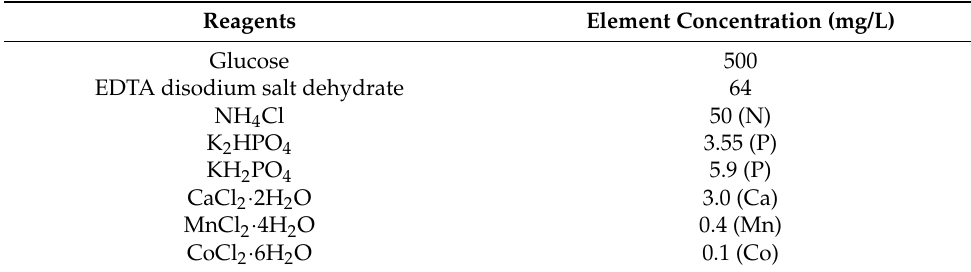
Table 2. Composition of synthetic municipal wastewater.